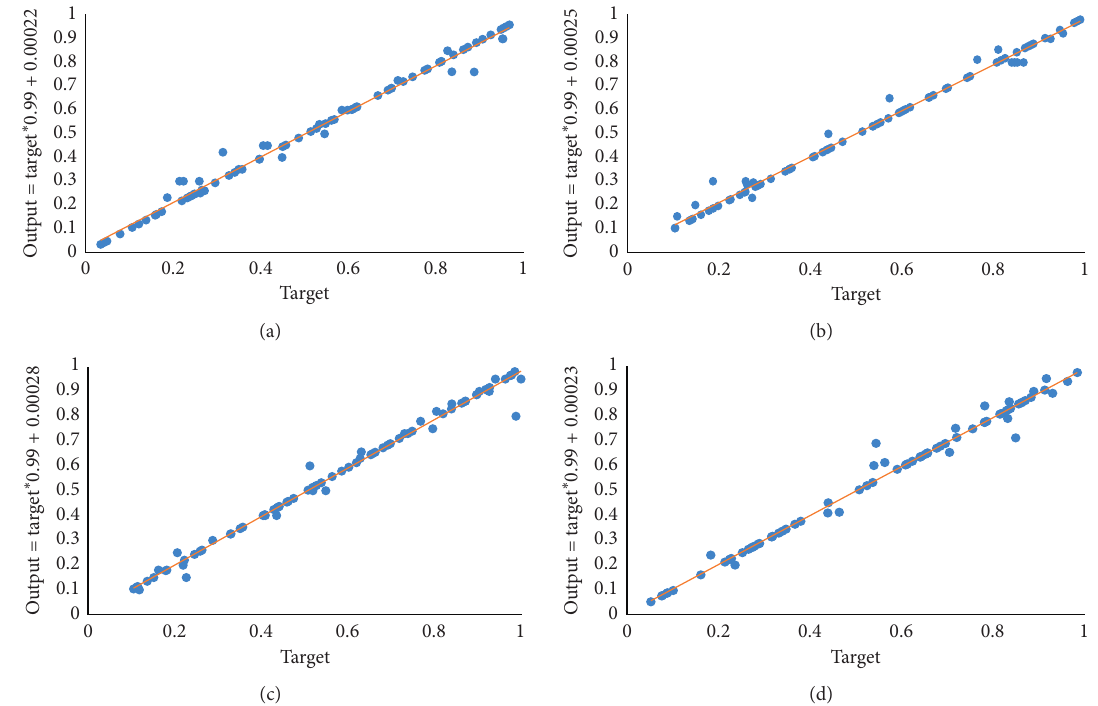
Figure 5: Neural network model fitting diagram: (a) R � 0.9959, (b) R � 0.99435, (c) R � 0.99464, and (d) R � 0.99518.